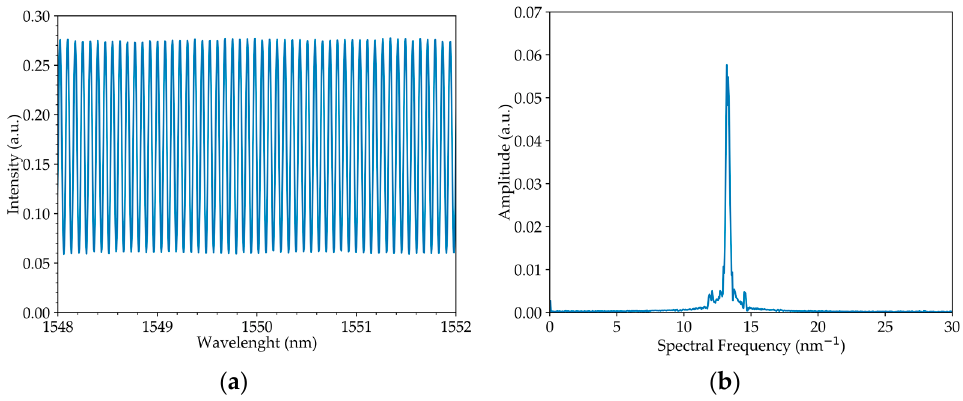
Figure 3. Output signal for two wave interference: ( a ) optical spectrum and ( b ) its Fourier Trans-